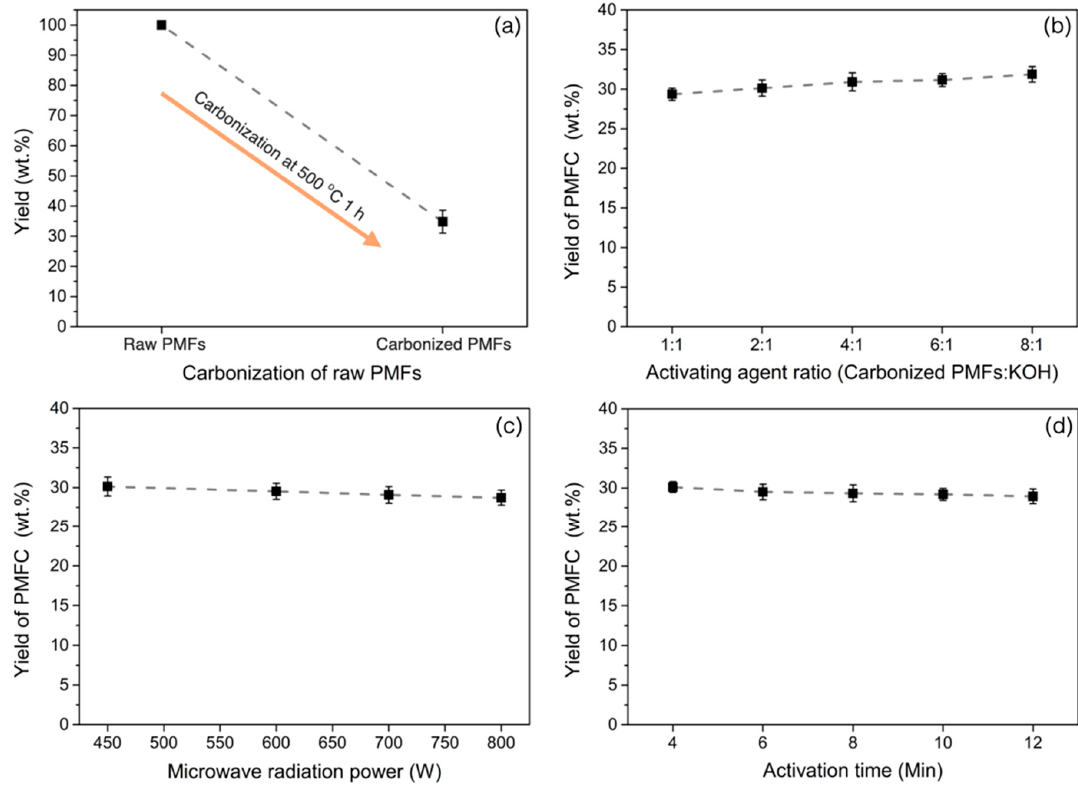
Figure 1. Effects of preparation variables on palm male flowers (PMFs) derived nanoporous carbon (PMFC) yield: ( a ) yield of carbonized PMFs at 500 °C, ( b ) effect of activating agent ratios, ( c ) effect of microwave radiation powers, and ( d ) effect of activation times. KOH, potassium hydroxide.